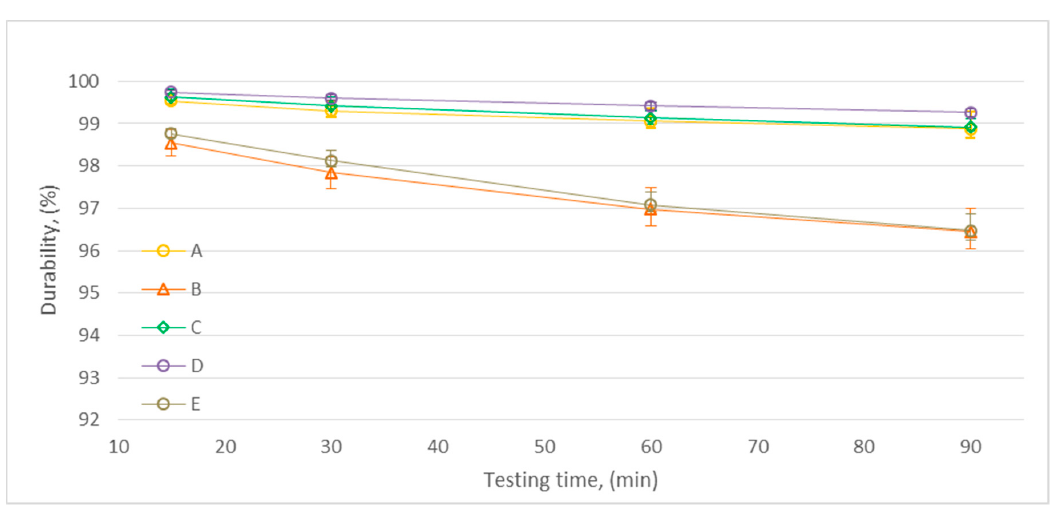
Figure 7. Influence of timing on durability of tested pellets in lateral vibration tests (own study). Table 3. ANOVA test results for the mass of crumbs due to lateral